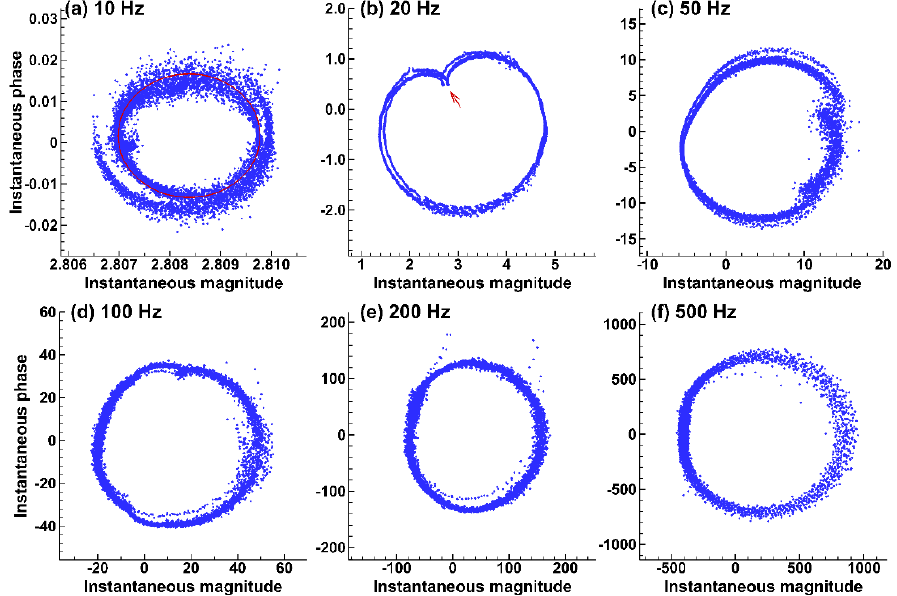
Figure 8. Phase space based on Hilbert transform of the sound signals at 0.3 m from the mouth opening with different glottal vibration frequencies: ( a ) 10 Hz, ( b ) 20 Hz, ( c ) 50 Hz, ( d ) 100 Hz, ( e ) 200 Hz, and ( f ) 500 Hz. The red ellipse in ( a ) is the sinusoidal waveform.